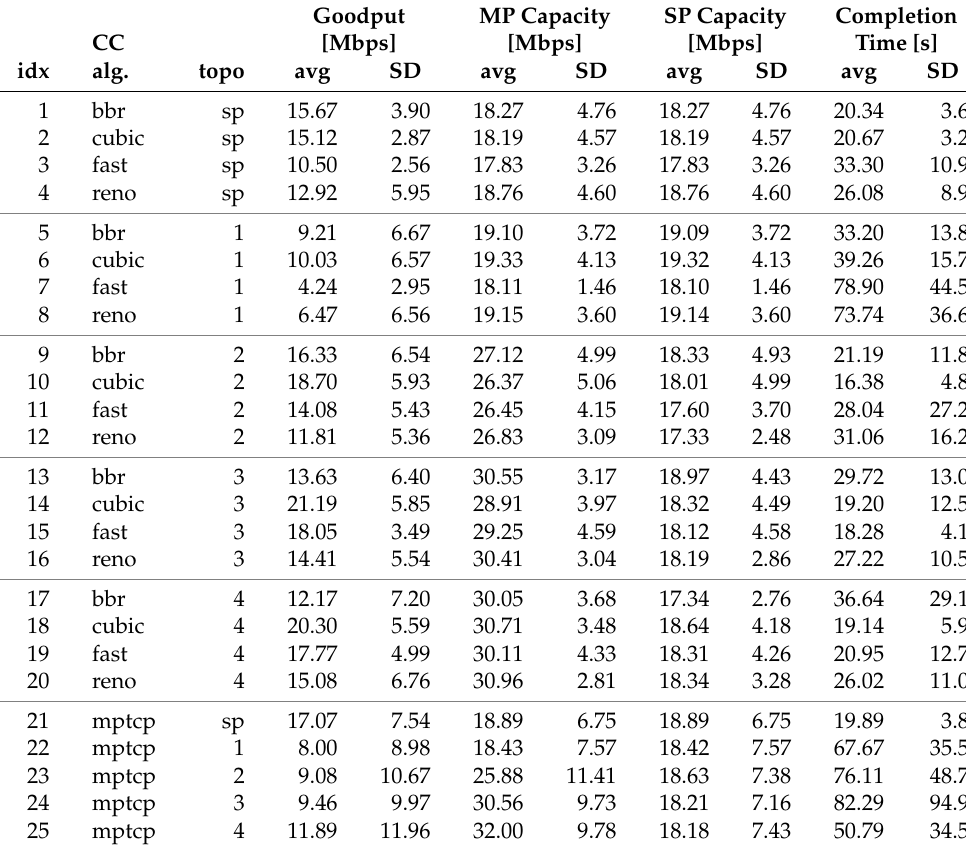
Table 5. Measurement results of Picoquic and MPTCP downloading a 40MB-sized file in the road